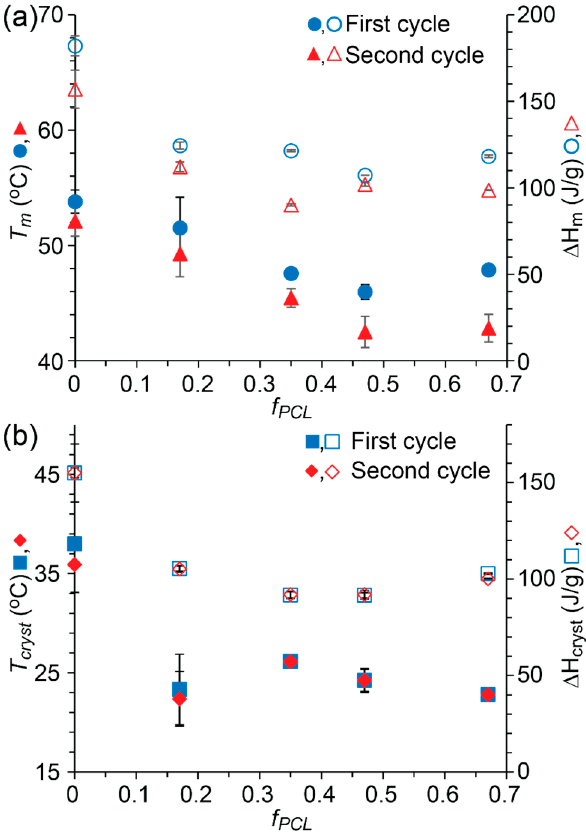
Figure 4. ( a ) T m and ∆ H m , ( b ) T cryst and ∆ H cryst of the PEG 2 homopolymer and PEG 2 PCL y copolymer series recorded during the first and second heating cycles as a function of f PCL (n = 5).